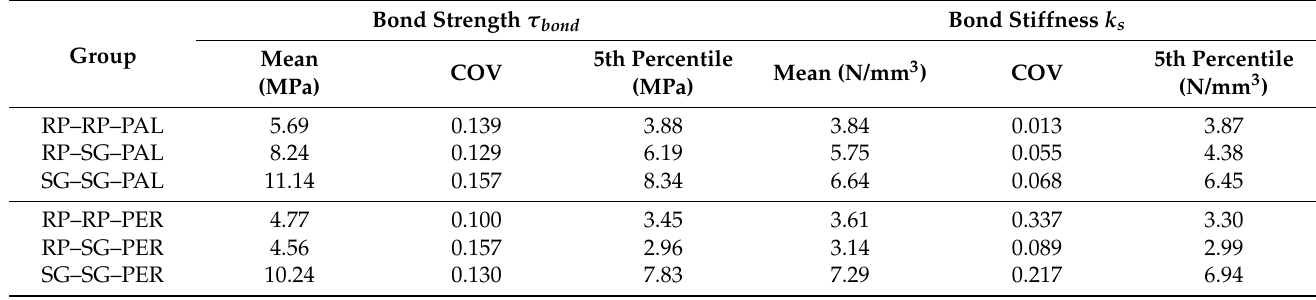
Figure 7. Bond characteristics of all tested samples. ( a ) Shear bond strength, ( b ) bond sti ff ness. Table 3. Mean and characteristic properties of bond strength and sti ff ness.